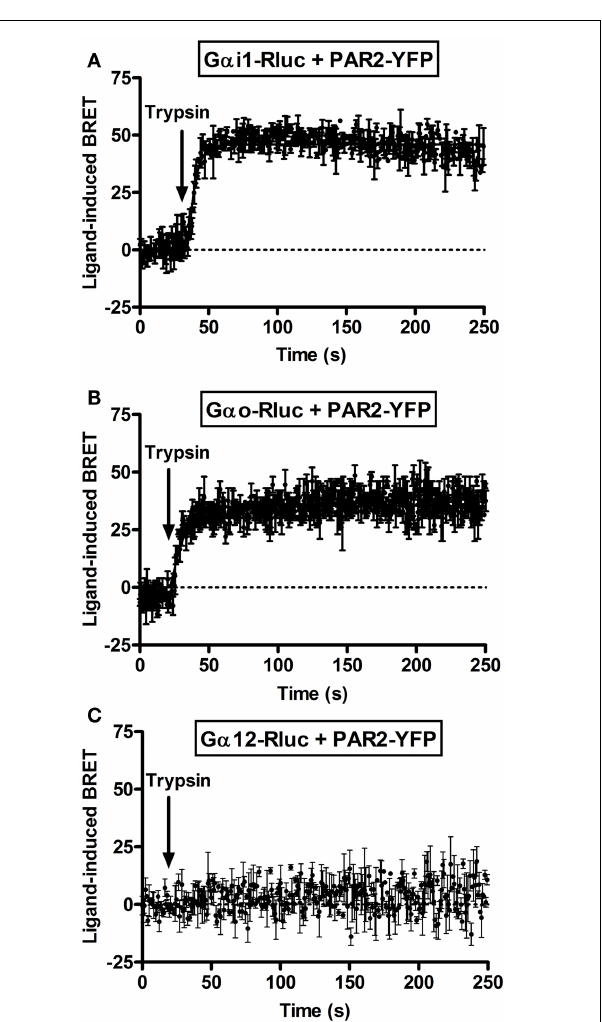
FIGURE 2 | Kinetic analysis of ligand-induced BRET increase between PAR2 and G α proteins . COS-7 cells transiently co-expressing PAR2-YFP and either G α i1-Rluc (A) , G α o-Rluc (B) , or G α 12-Rluc (C) were used for BRET experiments and repetitive signals were recorded before and immediately after the injection of 100nM of trypsin.The curves were fitted using “Plateau then increase to top” equation of Prism GraphPad software and Y = IF[ X < X 0, Plateau, Plateau + (Top − Plateau)*(1 − exp( − K * ( X − X 0)))] constraining the plateau to a theoretical value of 0. Data are mean ± SEM of three independent experiments performed in single points.